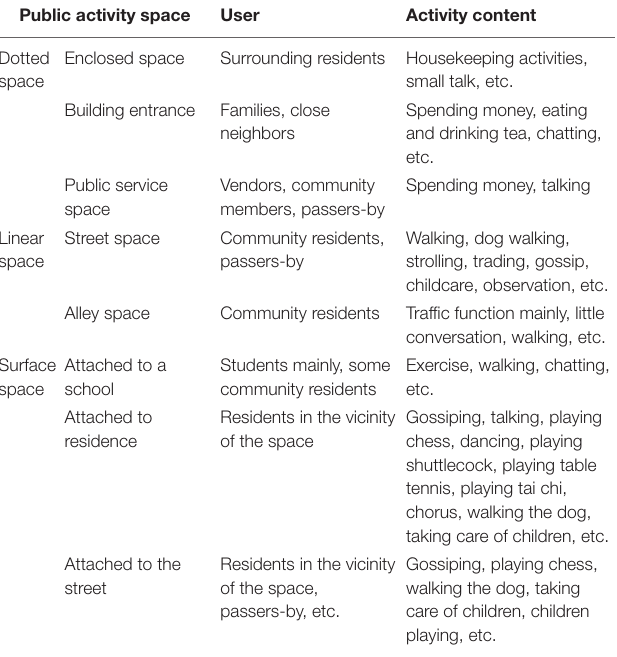
TABLE 5 | Analysis of crowd activities in the residential area of Fanghe Garden. Public activity